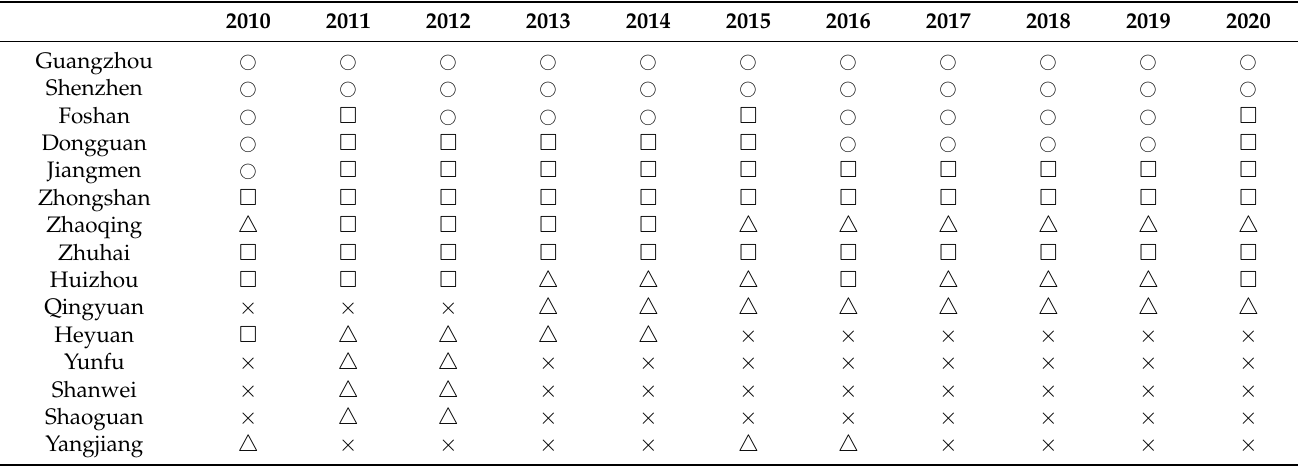
Table 7. Results of the block model of a housing prices’ association network in the PRDUA from 2010 to